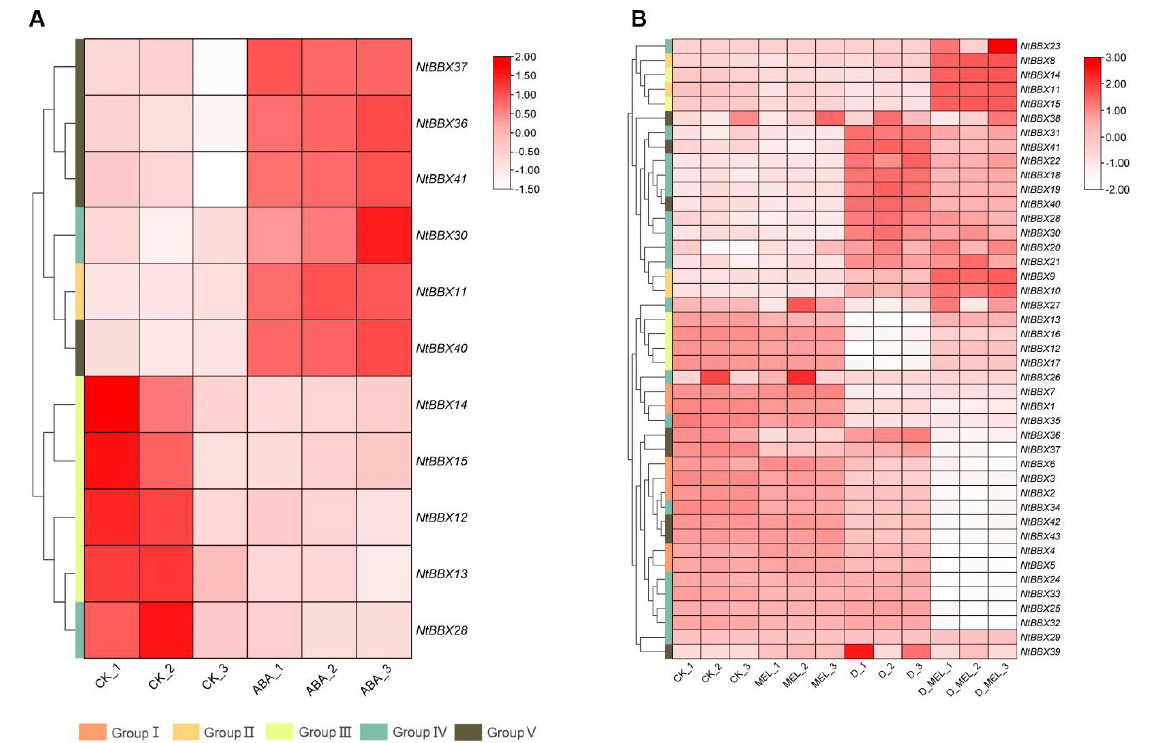
Figure 8. Expression of NtBBX genes under hormone induction. ( A ) Expression pattern of NtBBX genes under ABA treatment; ( B ) Expression pattern of NtBBX genes under dehydrate stress and melatonin treatment. D, dehydrate. MEL, melatonin. Subgroups Ⅰ–Ⅴ are represented by different colored boxes.